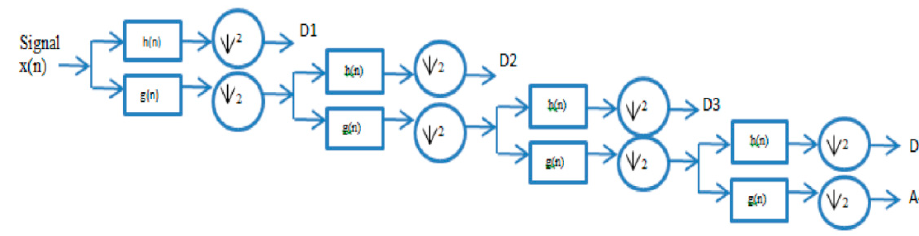
Figure 9. Decomposition multiresolution on four levels. The advantage of using UWT